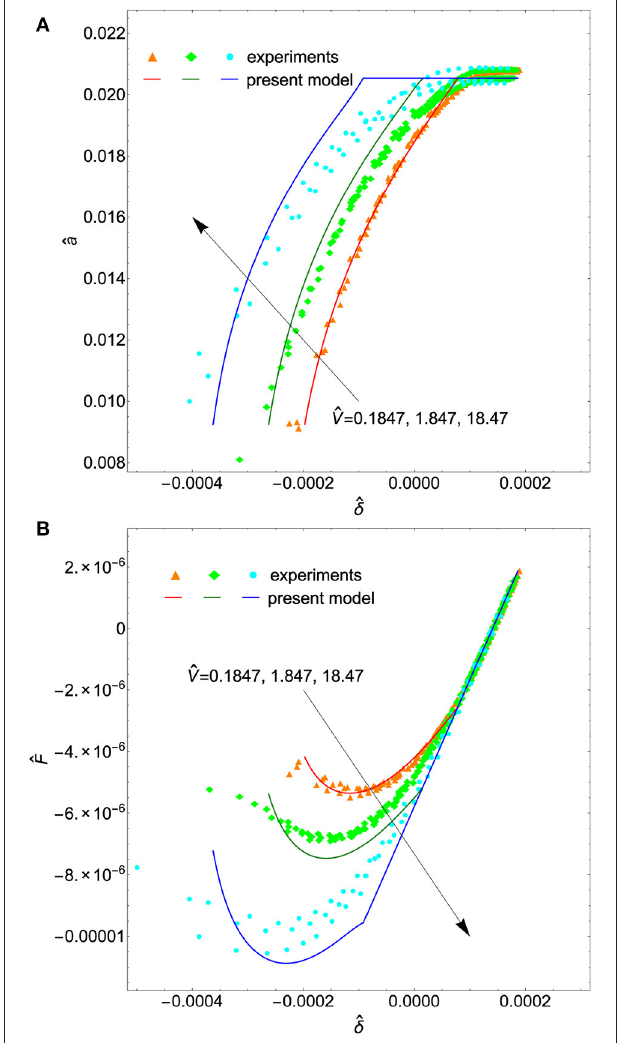
FIGURE 4 | Dimensionless contact radius ˆ a (A) and contact force ˆ F (B) as functions of the dimensionless approach ˆ δ for different driving velocities ˆ V = 0.1847, 1.847, 18.47 ( V = 0.2, 2.0, 20 µ m/s). Experimental data are plotted with colored markers, while solid lines are the theoretical predictions.